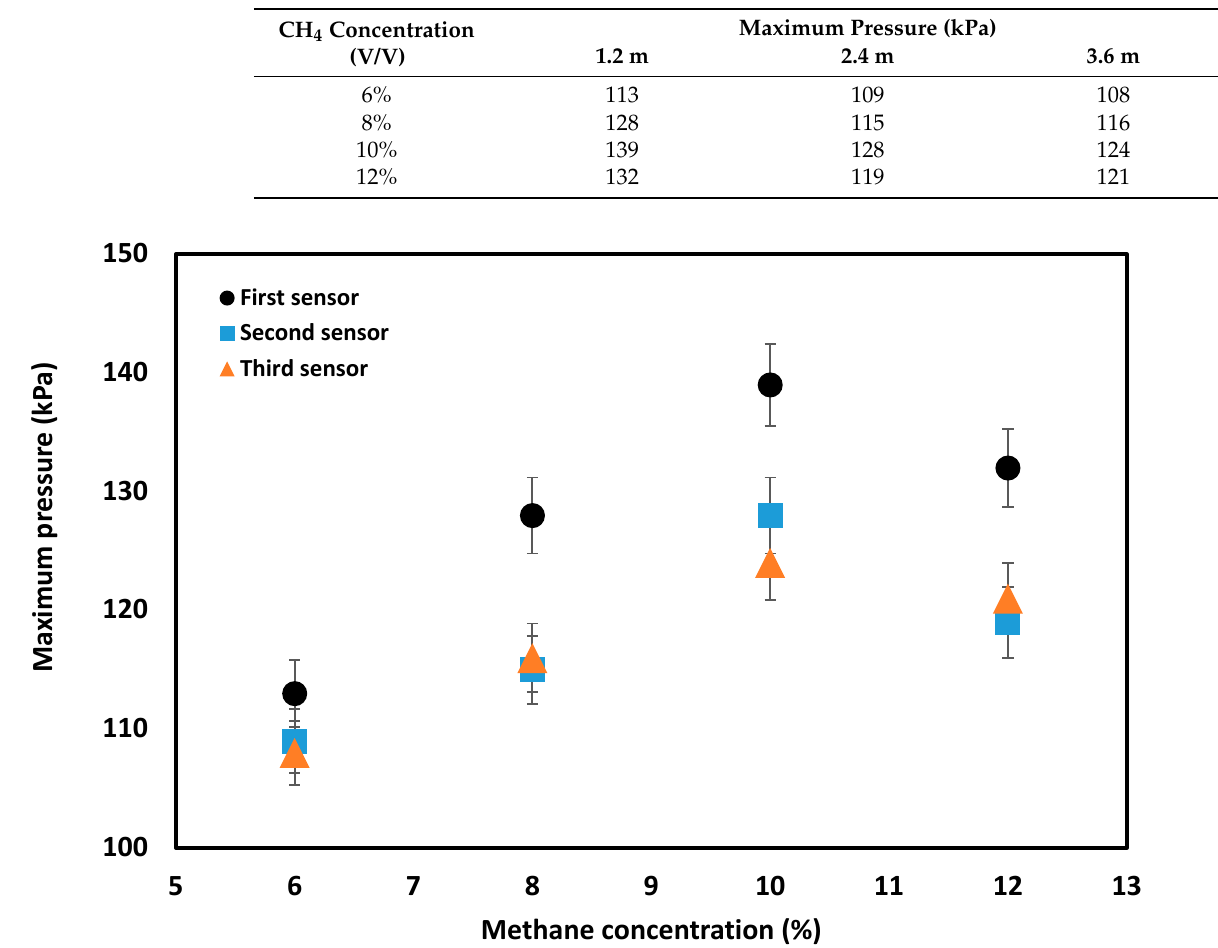
Table 2. Maximum pressure along the length of the flame propagation tube in the absence of obstacles.